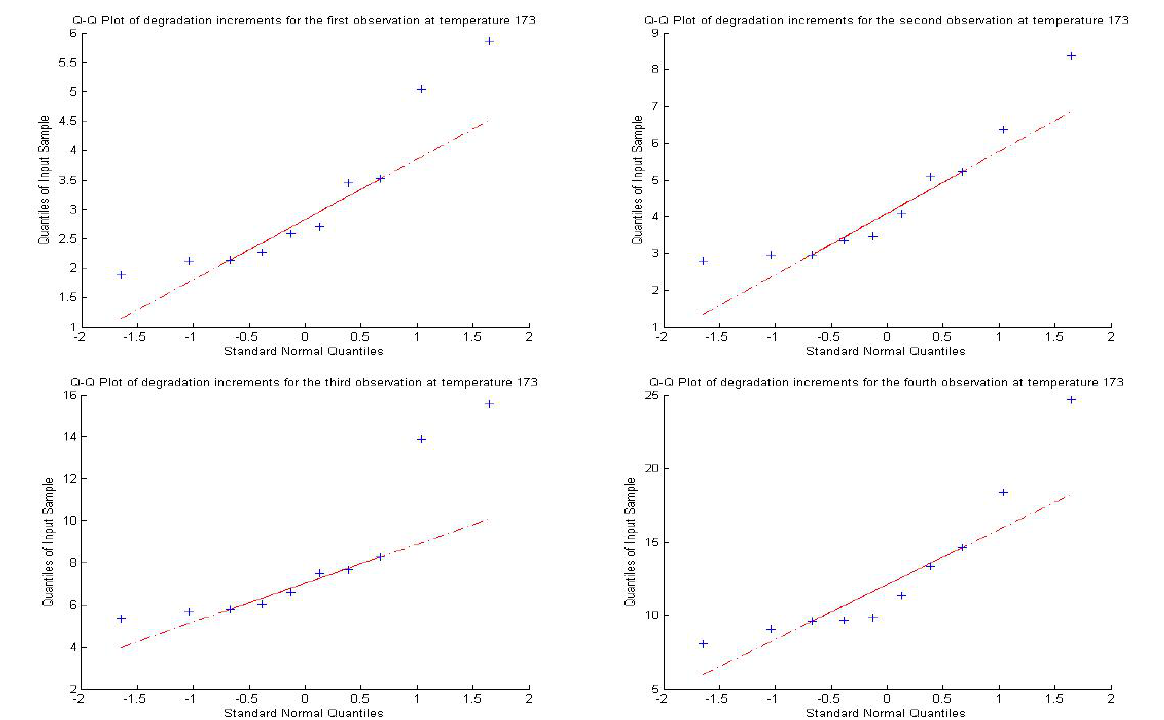
Figure 4. The Q-Q plot for degradation data at temperature 173 ◦